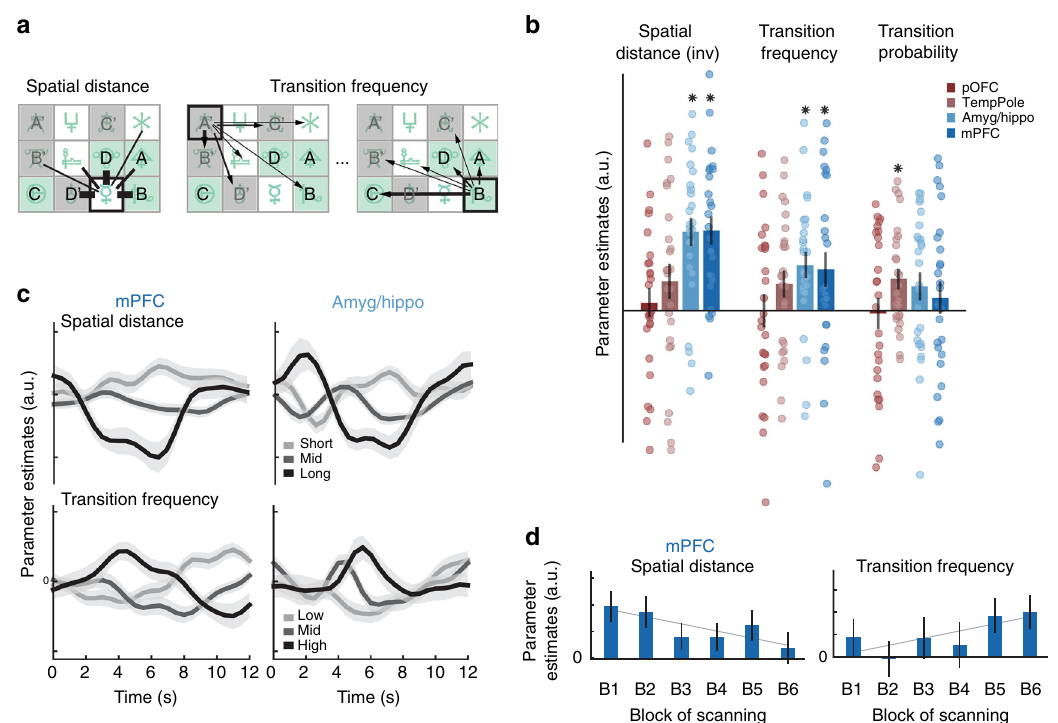
Fig. 4 Statistical knowledge of the task space in mPFC and amyg/hippo. a Two measures of statistical (incidental) knowledge were examined. In other words, stimulus – stimulus relationships that are true across all stimuli and independent of reward: spatial link distance, i.e., the number of steps from one element to another; and transition frequency, i.e., how often a transition from one element to another was experienced. Transition frequency was updated on a trial-by-trial basis (for model details, see Methods). b Both spatial link distance (sign- fl ipped for illustration) and transition frequency were re fl ected in BOLD activity in mPFC and amyg/hippo but not temporal pole or pOFC. Intriguingly, transition frequency (absolute measure of link between stimulus i and j) was a better predictor of activity in mPFC and amyg/hippo than transition probability (right: normalized measure of likelihood of going from i to j, given i), suggesting an absolute coding of the global task space rather than conditional knowledge of transitions normalized by the frequency of experiencing the initial states; * p < 0.05 in one-sample t -test. c Both effects are illustrated in both regions by separating trials into those with short/mid/long spatial distances (top), or low/mid/high transition frequency (bottom) between successive elements. d Spatial distance modulations decreased, and transition frequency modulations increased over time in mPFC. Error bars denote SE; see also Supplementary Fig.